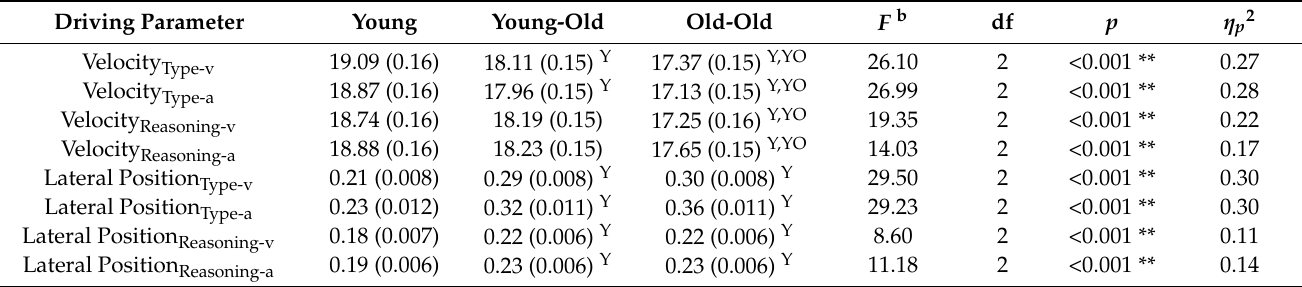
Table 3. Univariate follow-up results for the main effect of age.